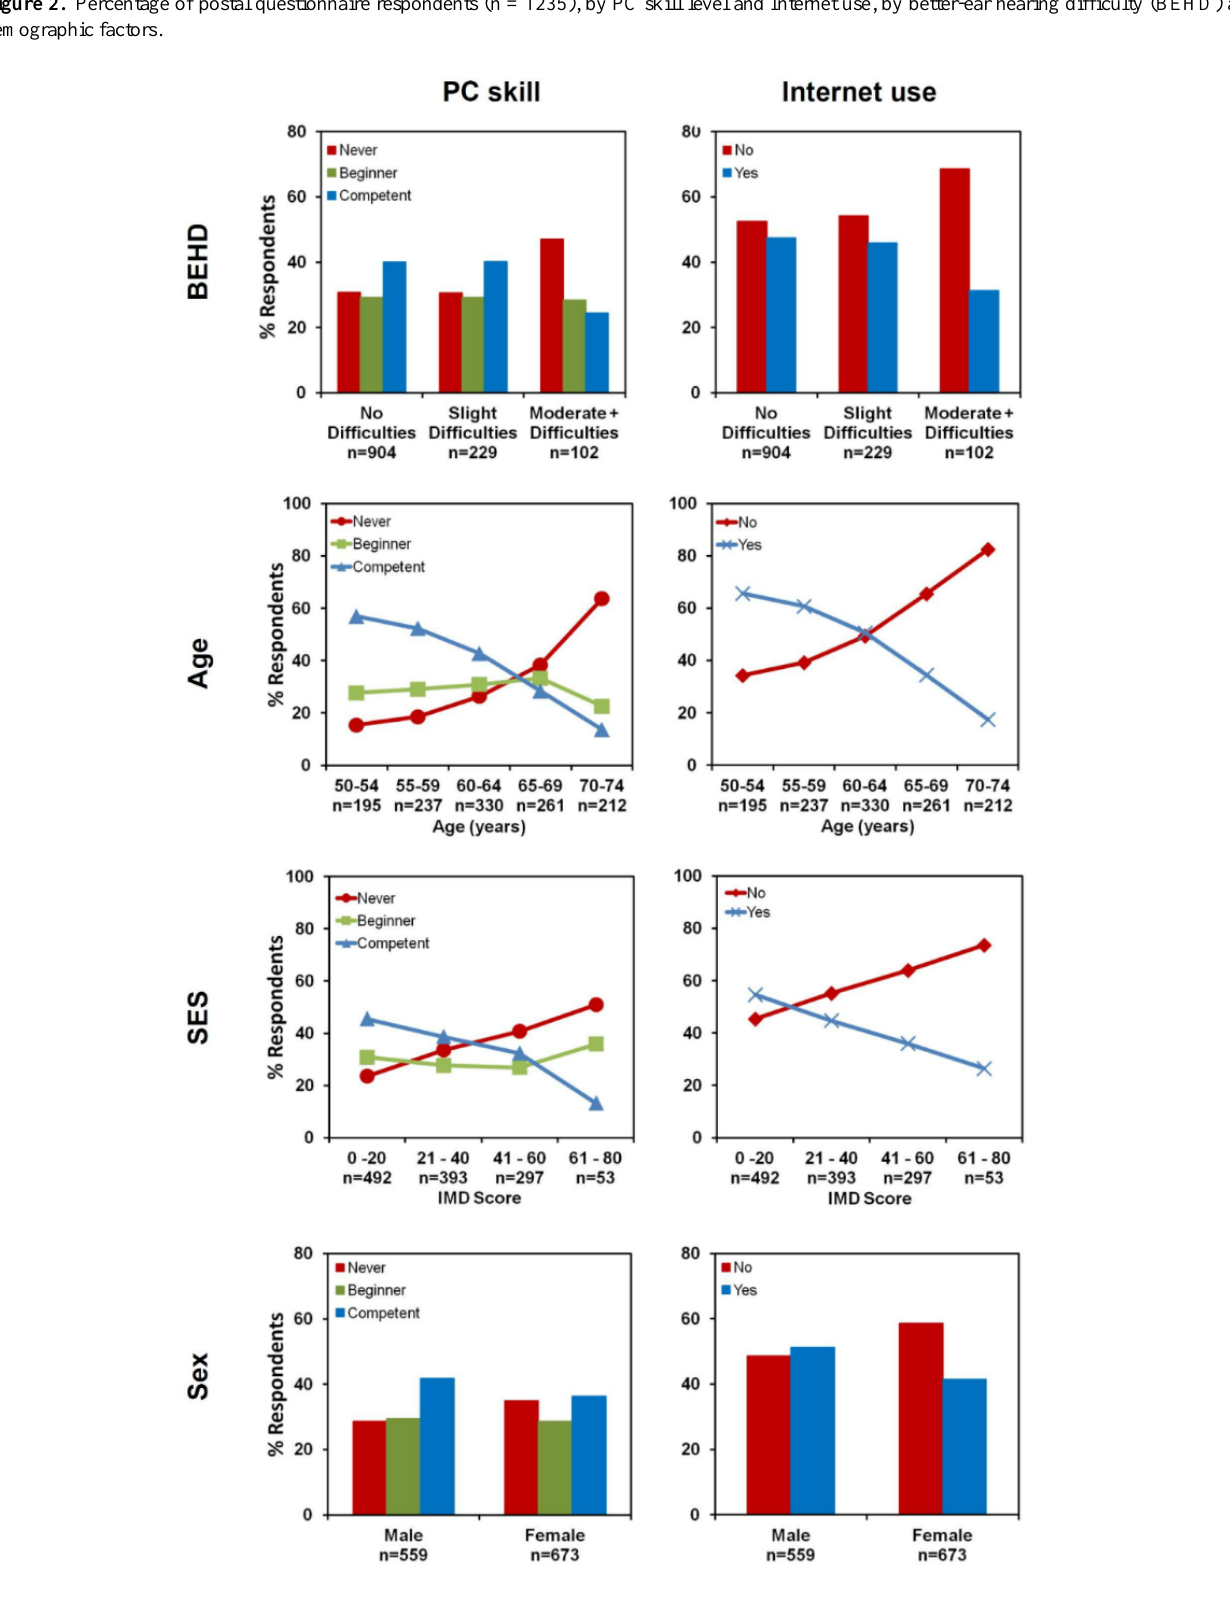
Figure 2. Percentage of postal questionnaire respondents (n = 1235), by PC skill level and Internet use, by better-ear hearing difficulty (BEHD) and demographic